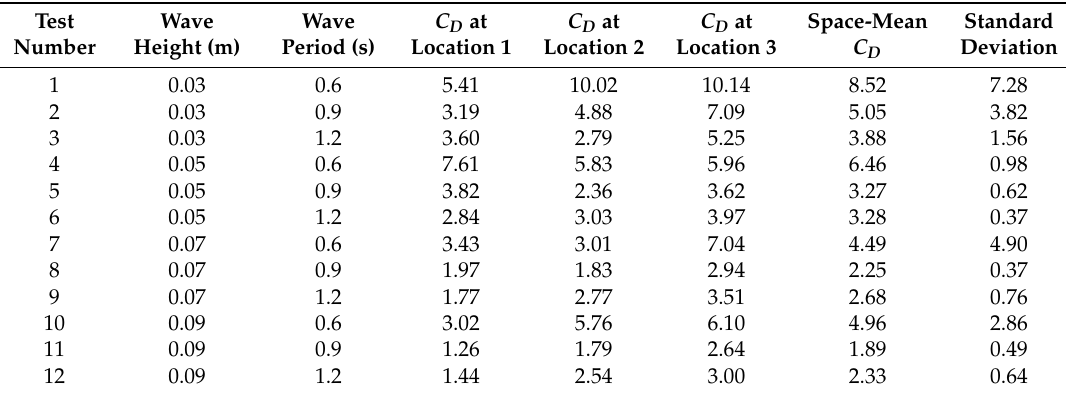
Table 2. Period-averaged C D in all the tested